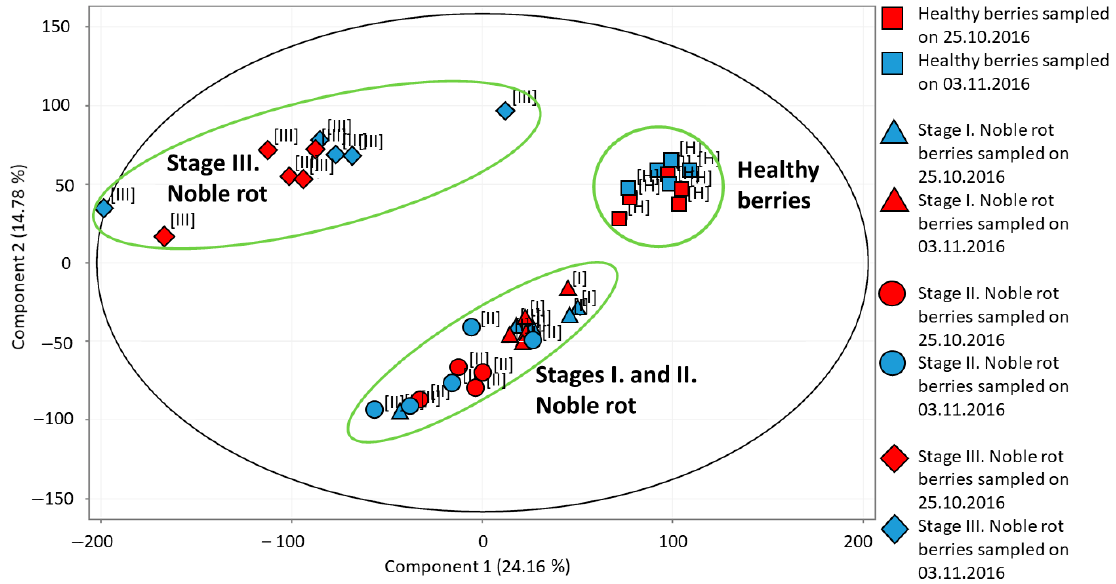
Figure 2. Principal component analysis of transcriptome profiles detected in various Vitis vinifera cv. Furmint berry samples. Healthy, stage I. noble rot, stage II. noble rot and stage III. noble rot samples were collected in October and November of 2016.